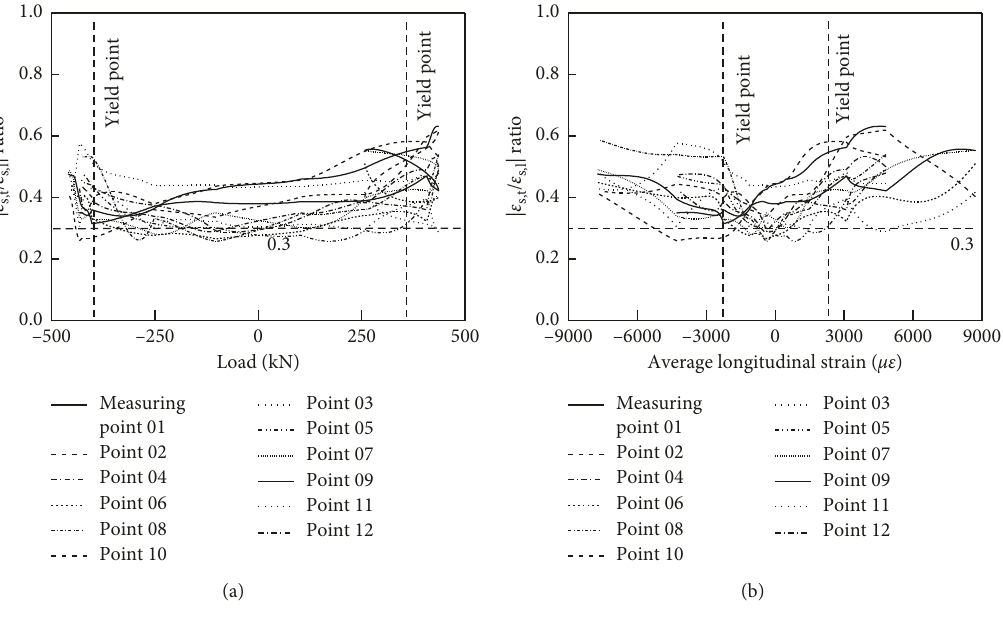
Figure 9: │ ε │ ratio variation of HST-1. (a) │ ε s,t / ε s,l strain.